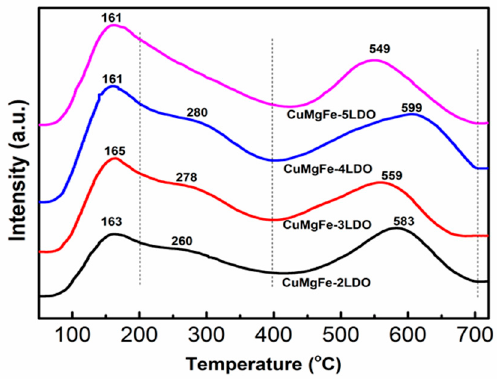
Figure 6. CO 2 -TPD patterns of the reduced CuMgFe-xLDO catalysts.